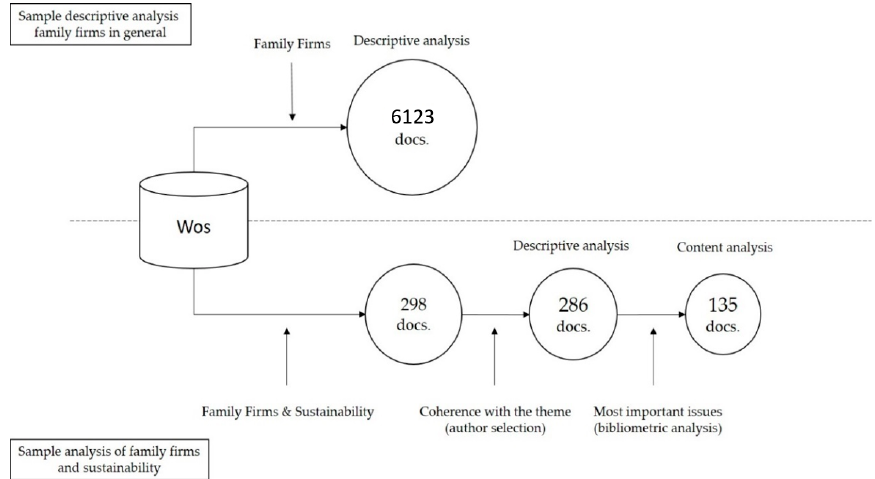
Figure 1. Number of publications used in the analysis. Source: Prepared by the authors.